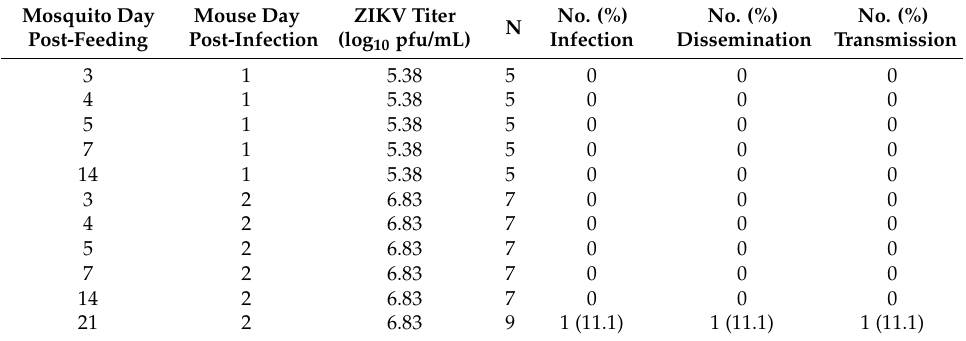
Table 1. Infection, dissemination, and potential transmission of ZIKV in Sabethes cyaneus fed on infected A129 mice.